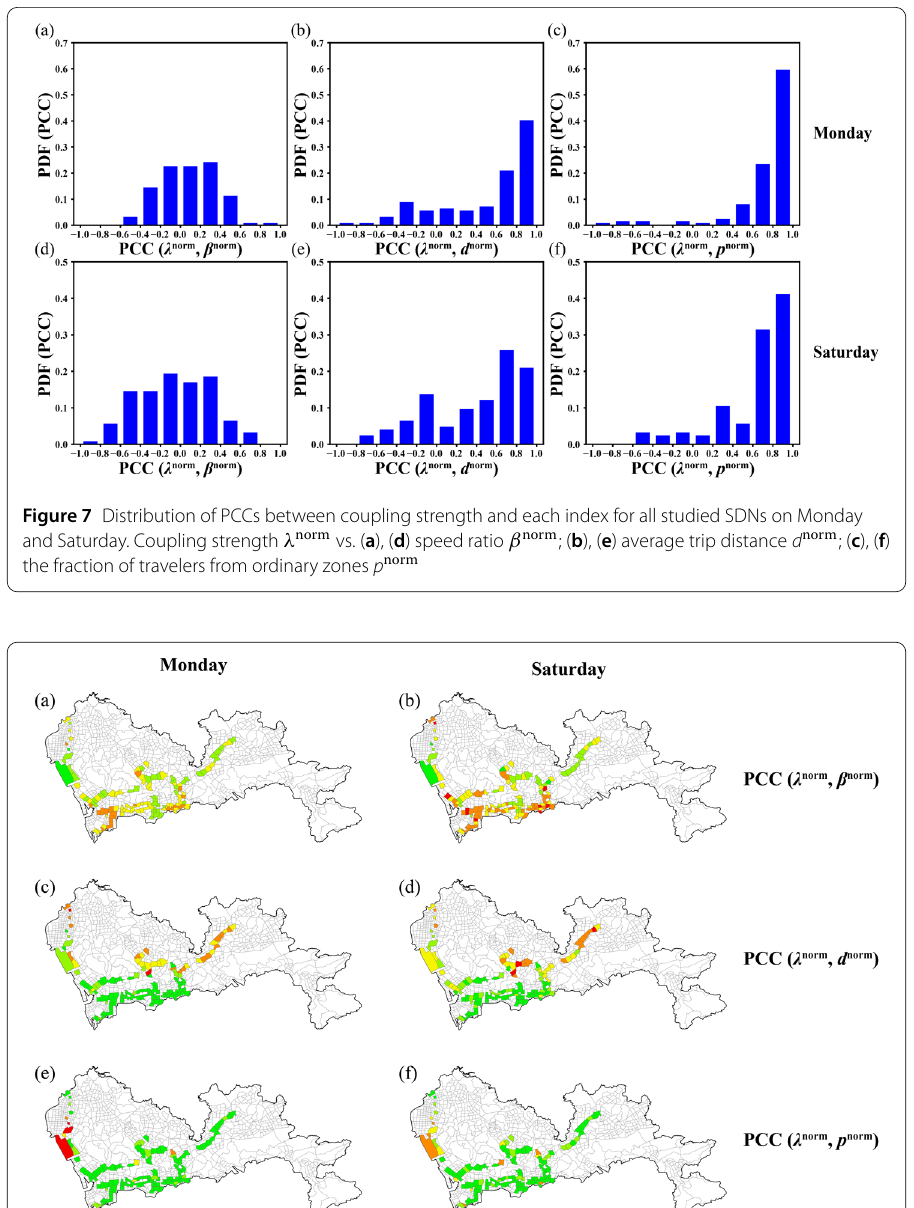
and coupling index λ norm ( t ) are located in the central urban area. The destination zones i ( t ) and λ norm ( t ) are located in of SDNs with weak or negative correlations between d norm i i the periphery area (Figs. 8(c), (d)). The peripheral destination zones attract long-distance travelers with less use of multimode transport, which is probably caused by that these zones attract many long-distance travelers from the city center with wide accessibility to public transportation. The destination zones of SDNs with strong positive correlations between p norm ( t ) and λ norm ( t ) are widely distributed across the investigated area. A i i